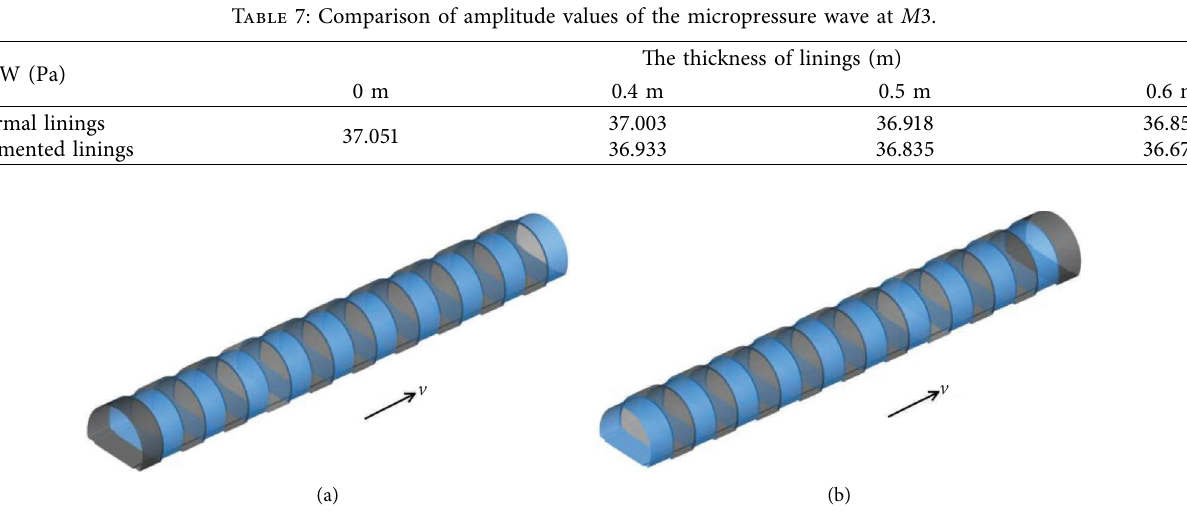
Figure 12: Diferent types of lining models. (a) Type 1. (b) Type 2.